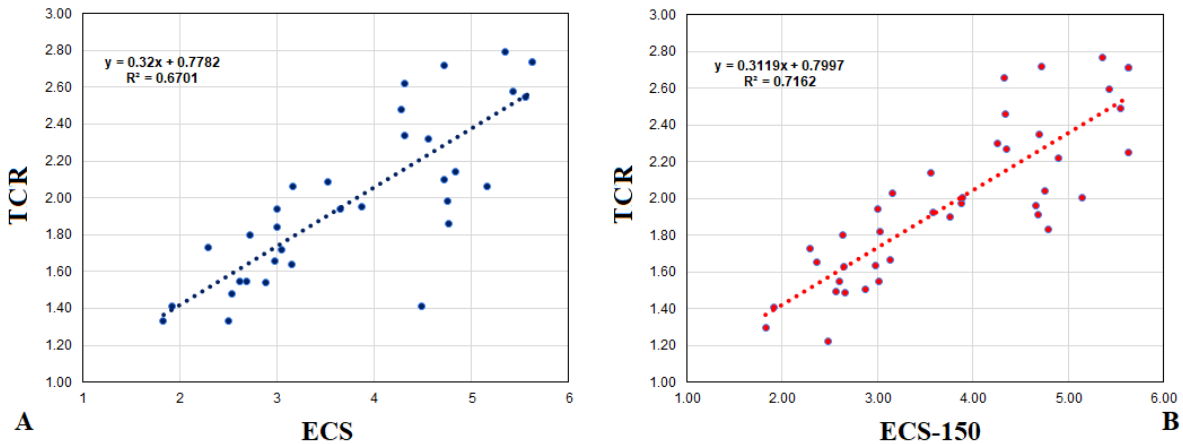
Figure 2. Equilibrium climate sensitivity (ECS) versus Transient Climate Response (TCR) of the CMIP6 Global Circulation Models (GCMs): ( A ) Data from IPCC [3] AR6, Table 7.SM.5; ( B ) Data from the supplementary information of Hausfather et al. [5]. See Table